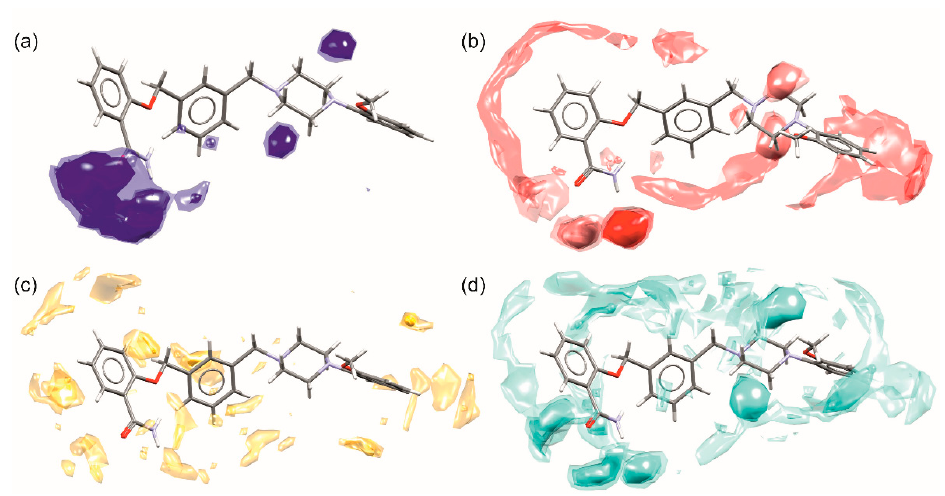
Figure 10. Full interaction maps of 1 showing the most probable contacts with ( a ) hydrogen bond donors, ( b ) hydrogen bond acceptors, ( c ) C-H donors and aromatic fragments, ( d ) water molecules. The darker color or small balls (hot spots) correspond to the most probable spatial placement of an important intermolecular interaction.